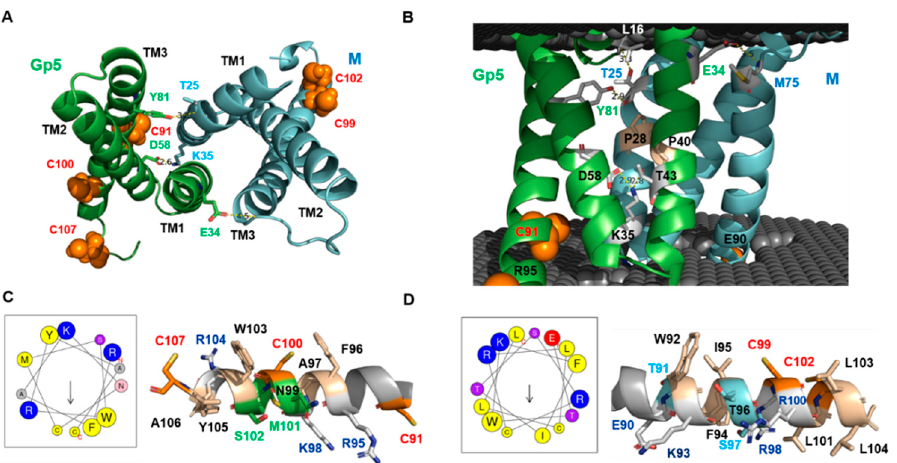
Figure 4. The structure of the transmembrane region of Gp5/M of PRRSV-2. ( A , B ) Top view and side view of the transmembrane region, the latter embedded in a virtual lipid bilayer. Palmitoylated Cys in Gp5 and M are shown as orange spheres. Conserved Pro in the middle of TM1 of both Gp5 and M are highlighted as wheat sticks in ( B ). Amino acids that form ionic interactions between Gp5 and M are highlighted as sticks. Asp58 forms an ionic bond with Lys35 in M, which is located in the loop between TM1 and TM2 and also interacts with Thr43 in TM1 of Gp5. In the outer membrane leaflet, the hydroxyl group of Tyr81 in TM3 of Gp5 interacts with the main chain in TM1 of M at position Thr25. The side chain of this Thr interacts with the main chain of the ectodomain of Gp5 at position Leu16. Finally, Glu34 in TM1 of Gp5 interacts with the main chain of M at position 75 located at the end of the loop connecting TM2 and 3. ( C , D ) Heliquest analysis of the C-terminal region of TM3 of Gp5 ( C ) and M ( D ) and structure of the corresponding domain. Heliquest produces a helical wheel from the sequence with an arrow inside that points to the hydrophobic face. Its length corresponds to the hydrophobic moment. A hydrophobicity <H> of 0.483 and a hydrophobic moment <µH> of 0.447 was calculated for Gp5, whereas the corresponding values for M are <H> 0.723 and <µH>: 0.335.